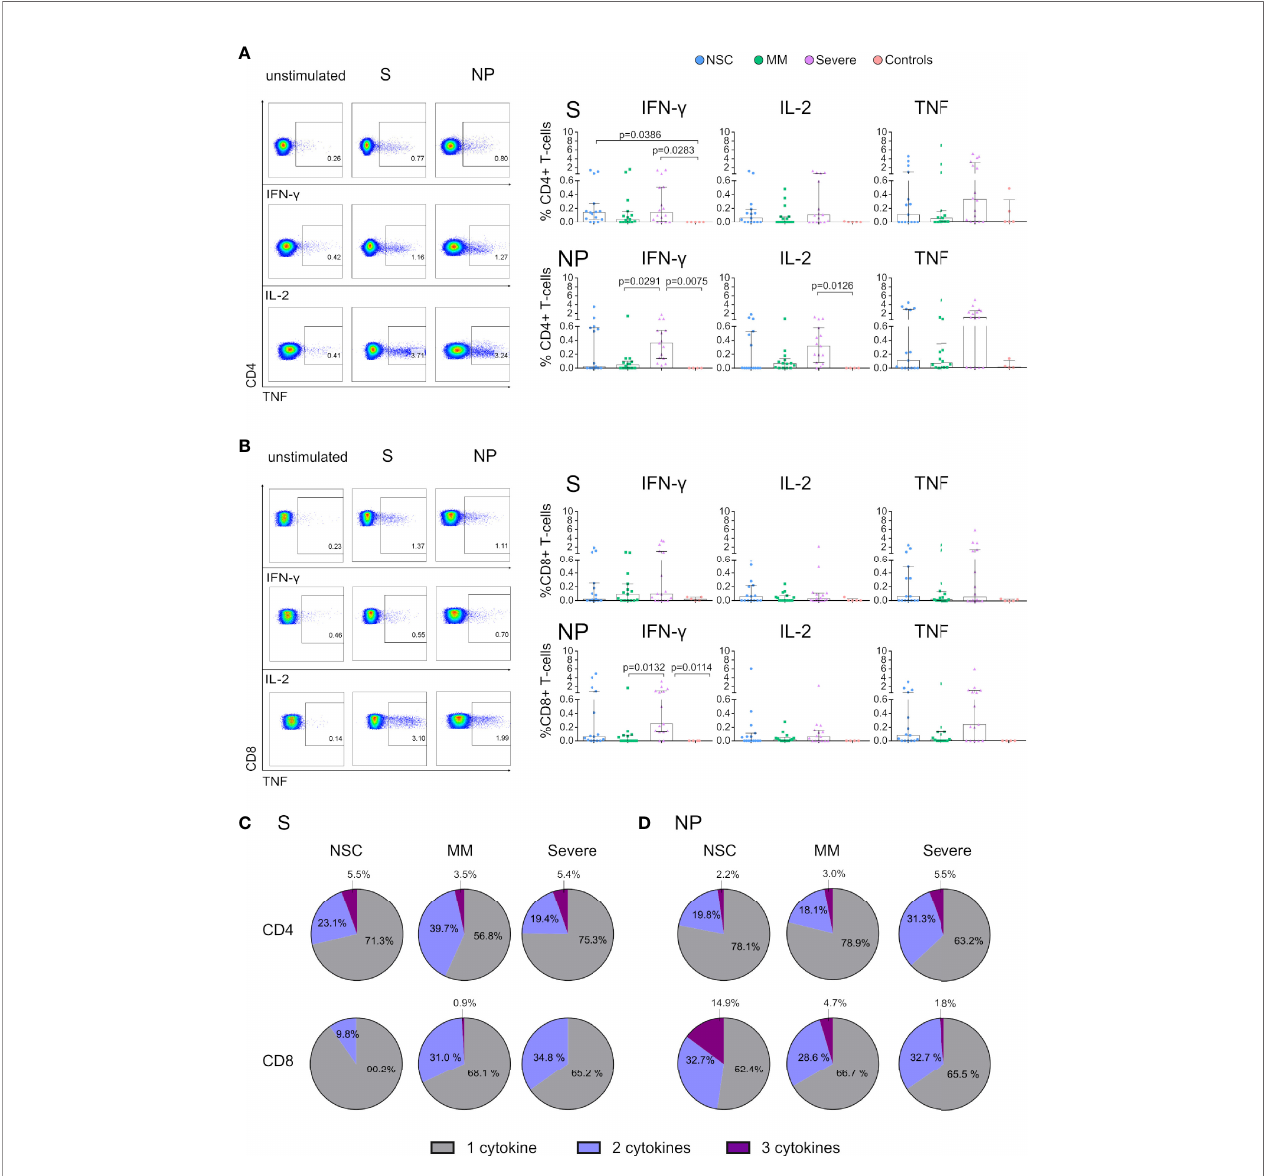
FIGURE 3 | Functional T cells of SARS-CoV-2 Non-Seroconvertors are present in NSC in response to Spike and Nucleocapsid. Cryopreserved PBMCs from SARS- CoV-2 Non-Seroconvertors (NSC) and comparative study groups, Mild-moderate (MM), Severe, and controls samples were stimulated for 17 hours with Spike (S) and Nucleocapsid proteins (NP). An unstimulated condition was used as a control and values were subtracted. Cells were pre-gated for lymphocytes and live cells. Production of IFN- g , IL-2, and TNF was monitored by Flow cytometric analysis following intracellular cytokine staining. (A, B) Left panels depict the gating strategy for analysis of cytokine expression and right panels represent the frequencies of IFN- g , IL-2, and TNF in CD4+ (A) and CD8 (B) T cells in the study groups in response to S and NP. Pie charts demonstrate the relative proportions of T cells producing one, two or three cytokines in response to S in CD4+ T cells and CD8+ T cells (C) . Relative proportions of T cells producing one, two or three cytokines in response to NP in CD4+ T cells and CD8+ T cells (D) . Statistical analysis was performed using non-parametric ANOVA (Kruskal Wallis) adjusted for multiple comparisons. Error bars represent the interquartile range and median values per group are shown. Only signi fi cant differences are indicated in the